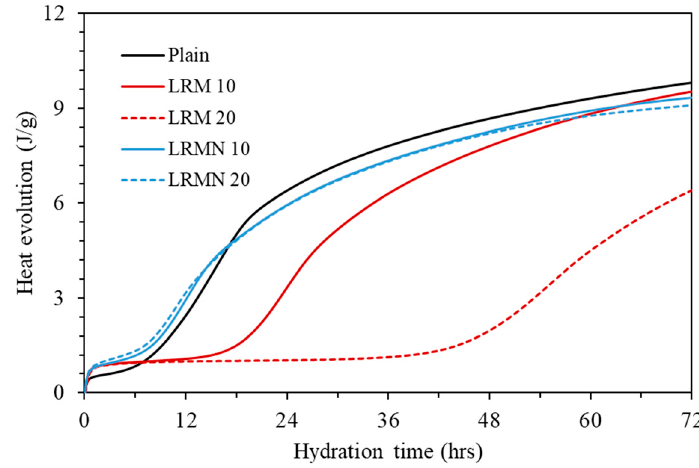
Figure 7. Accumulative hydration heat of the various cement pastes over time.